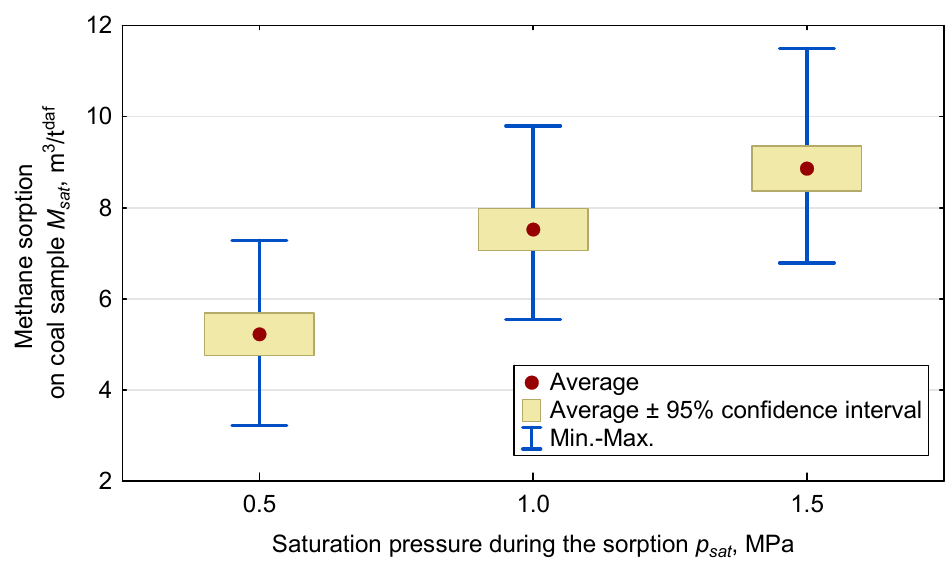
Figure 1. Methane sorption on coal samples M sat for different saturation pressures p sat . For each of methane saturated coal samples, the pressure in gravimetric microbalance IGA-001 was reduced to 0.1 MPa. Then the process of methane desorption from coal samples was analysed. Particular attention was paid to the first 10 min of the desorption pro- cess.